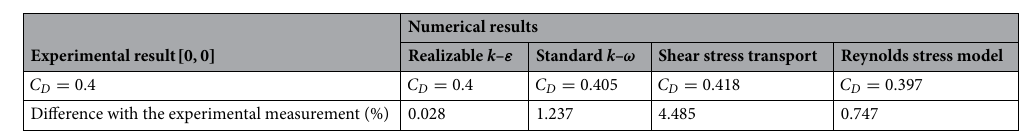
Table 2. Validation of numerical